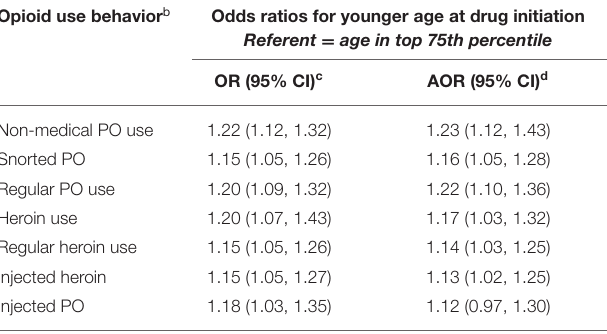
TABLE 4 | Associations of number of adverse childhood events (ACE) a and age at initiation of opioid use behaviors among young adult opioid users in New York City,